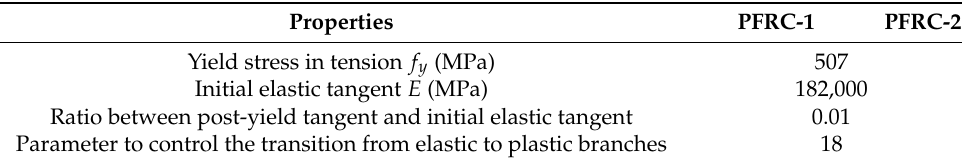
Table 4. Parameters in Steel